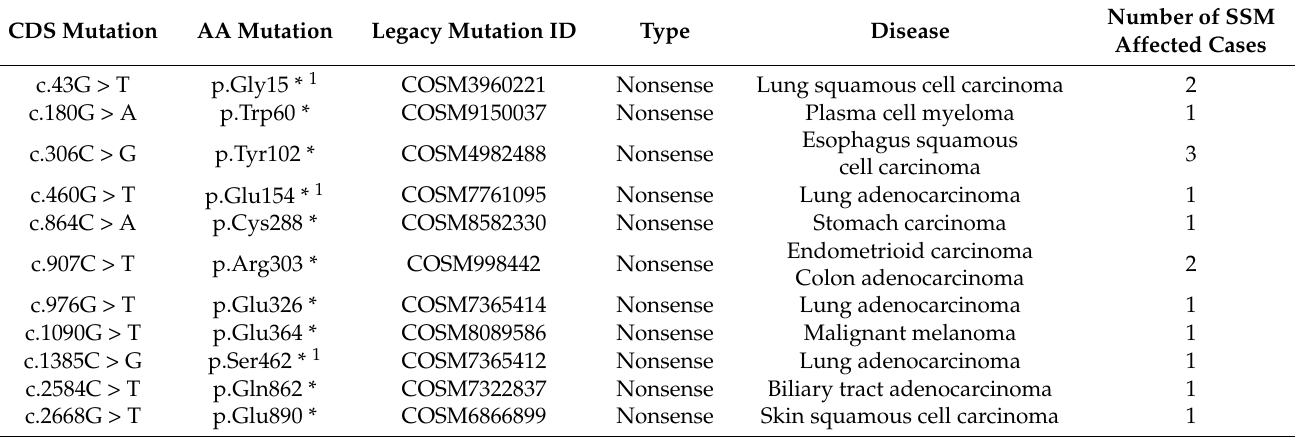
Table 5. DPP9 LoF variants in COSMIC. Nonsense mutation that is a substitution mutation resulting in a premature termination codon (*). CDS = coding sequence; AA = amino acid; SSM = simple somatic